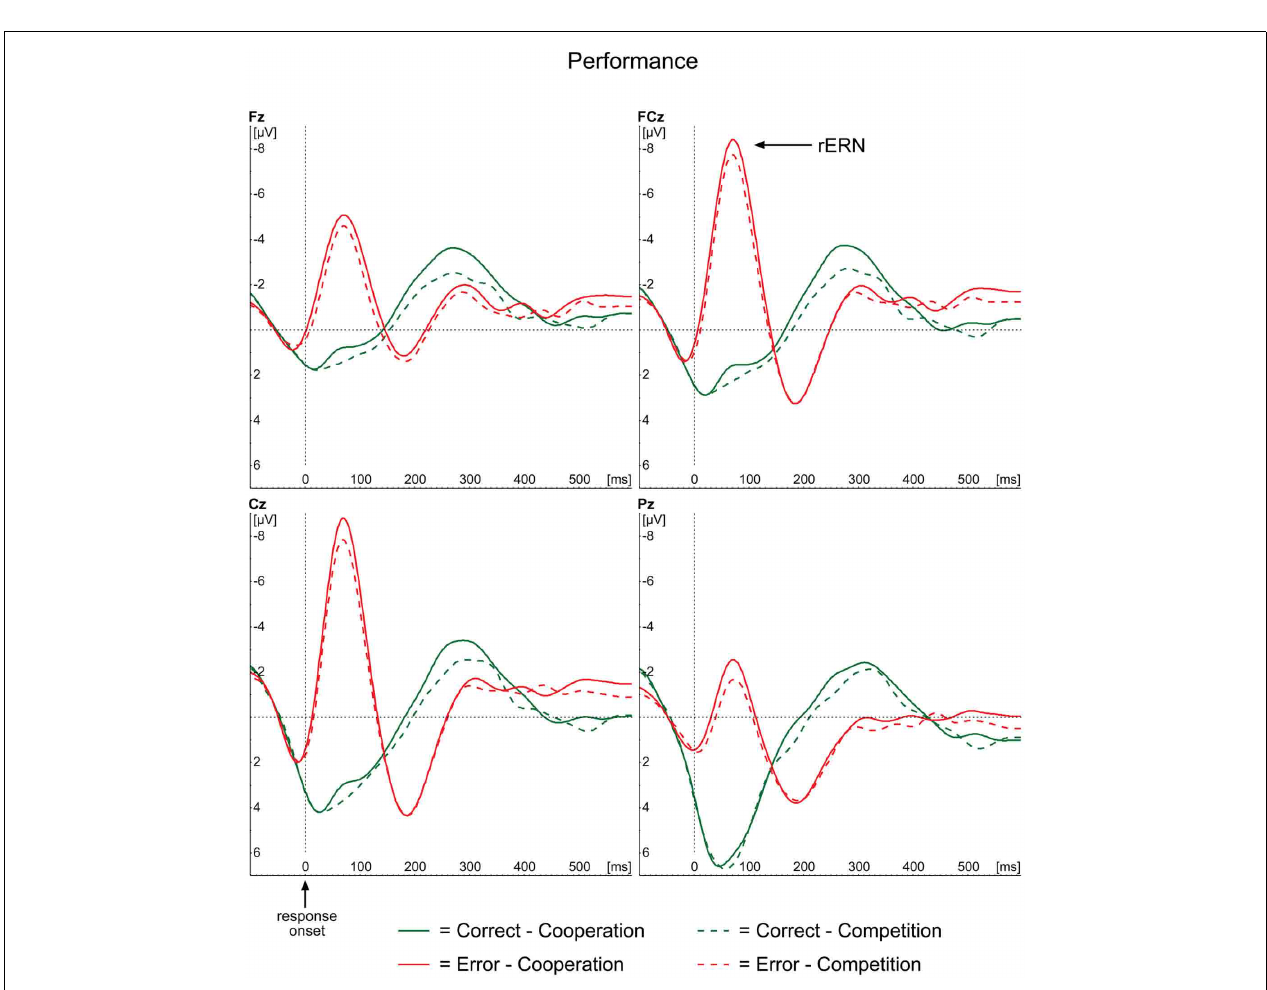
FIGURE 2 | Grand average ERP waveforms for the performance condition, time-locked to the onset of the actor’s response for correct (green lines) and incorrect (red lines) responses separately. Midline electrodes Fz, FCz, Cz, and Pz are